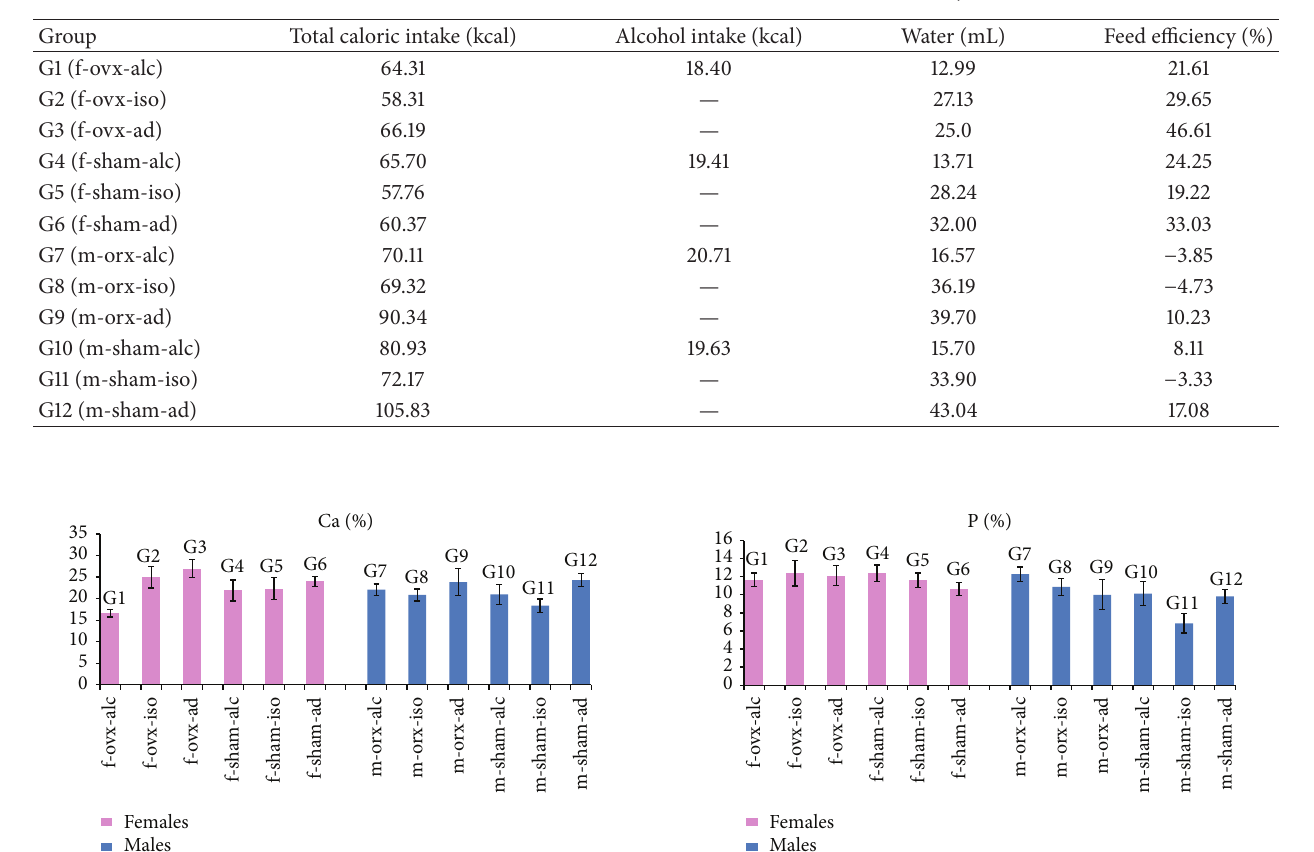
Table 2: Total caloric intake, alcohol intake, water, and feed efficiency.